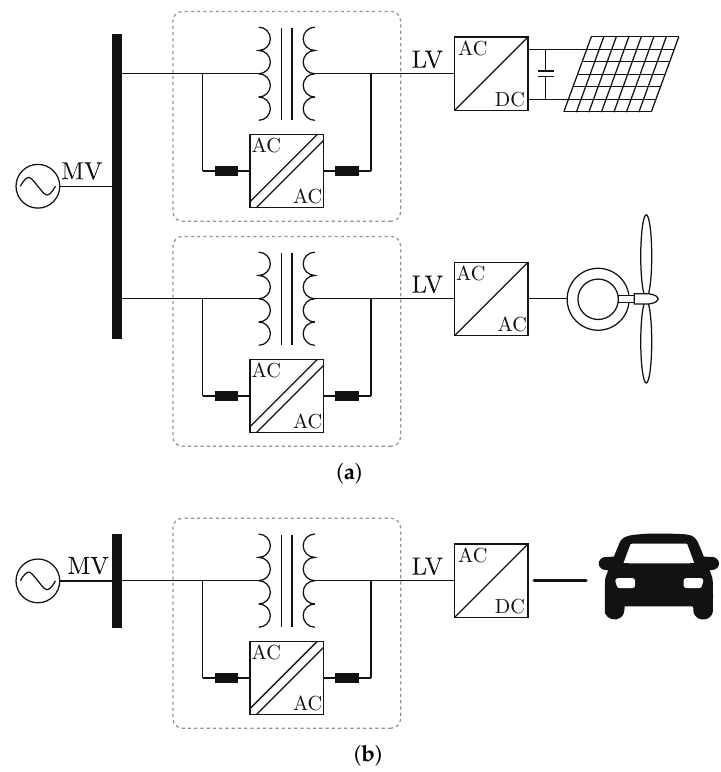
Figure 23. HDTs for the integration of renewable systems and new kind of loads. ( a ) Renewable systems integration. ( b ) Electric vehicle charging